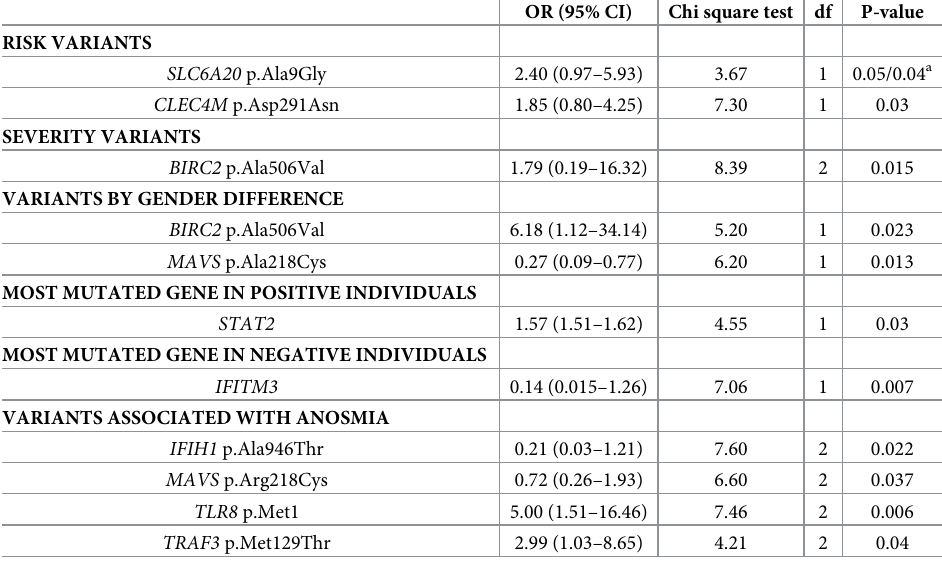
Table 6. Statistical global analysis of the gene